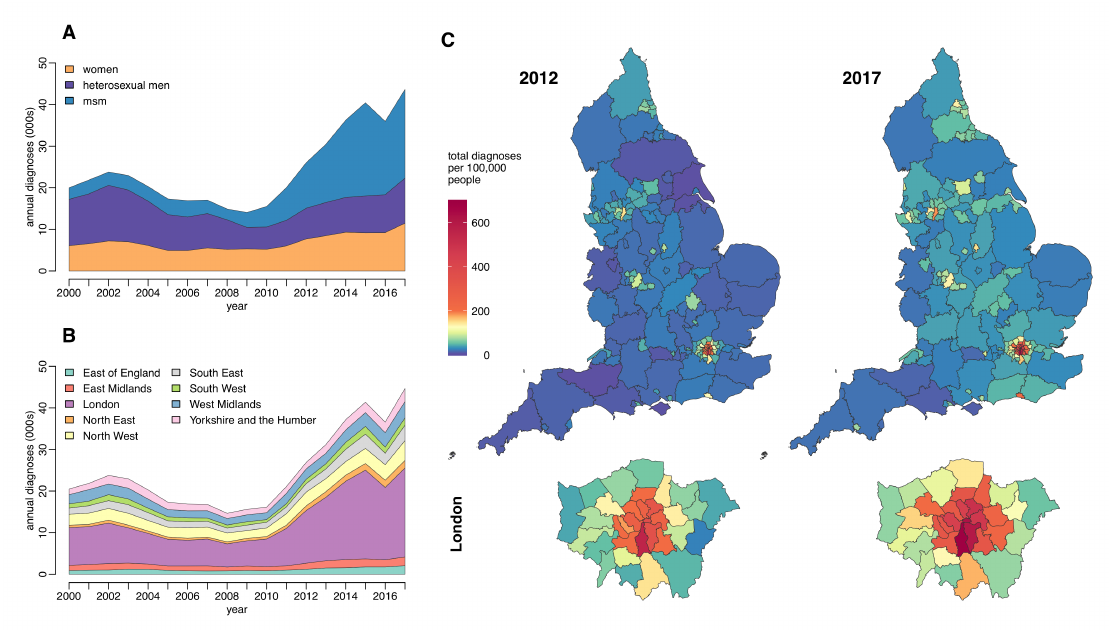
Figure 1. Total annual gonorrhoea diagnoses in England split by ( A ) gender and male sexual behaviour ( B ) and region ( C ) Comparison of the rate of gonorrhoea diagnosis per 100,000 people across regions of England and London boroughs in 2012 and 2017. Data on sexually-transmitted infection diagnoses and rates published by Public Health England (PHE) and accessed using the Fingertips R package [18].